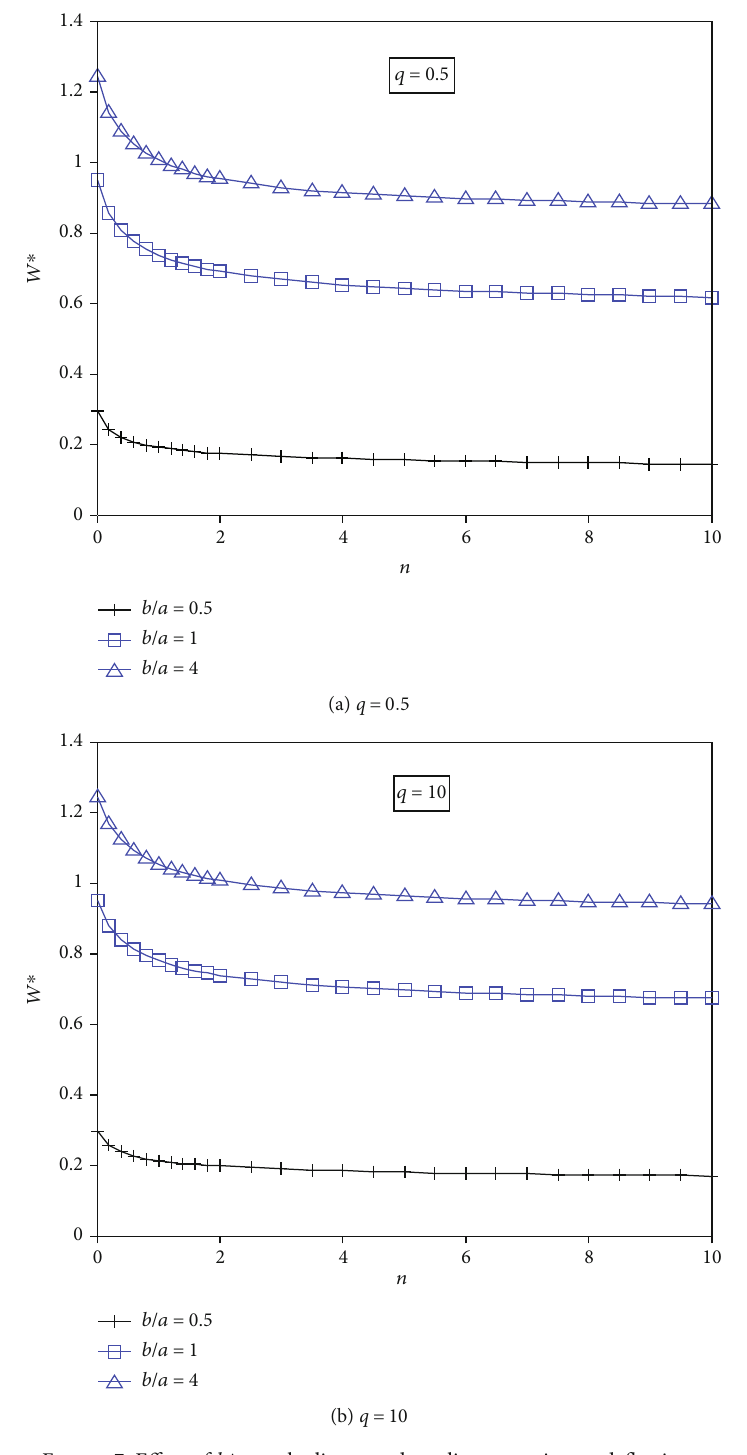
Figure 7: E ff ect of b / a on the linear and nonlinear maximum de fl